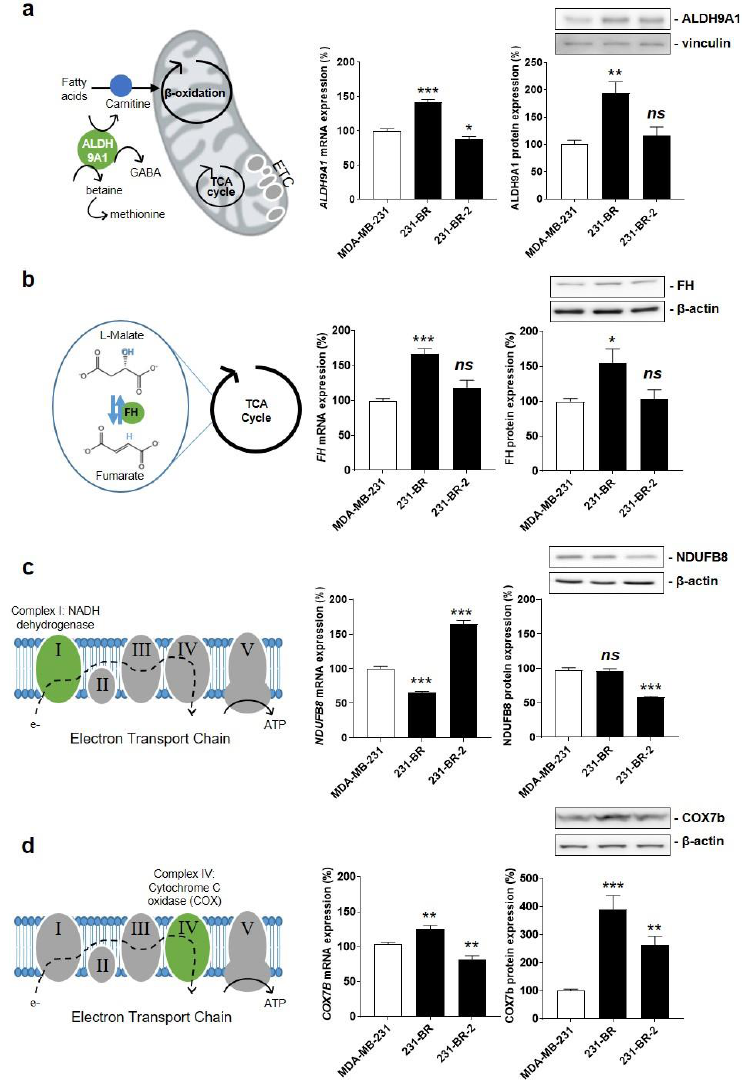
Figure 3. Identification of Cox7b as a candidate protein for the brain tropism of human breast cancer. ( a ) The left drawing depicts the three main functions of aldehyde hydrogenase 9A1 (ALDH9A1) that catalyzes the biosynthesis of γ -aminobutyric acid (GABA) in the cytosol, the biosynthesis of carnitine to facilitate the transport of fatty acids across the inner mitochondrial membrane, and the oxidation of γ -aminobutyraldehyde and aminoaldehydes derived from polyamines in the mitochondrial matrix. The middle graph shows ALDH9A1 mRNA expression normalized to β -actin ( n = 5–6), and the right graph shows ALDH9A1 protein expression normalized to vinculin ( n = 6), in MDA-MB-231, 231-BR, and 231-BR-2 cancer cells. ( b ) The left drawing depicts fumarate hydratase (FH) activity, which catalyzes the reversible hydration of fumarate to malate in the TCA cycle. The middle graph shows FH mRNA expression normalized to β -actin ( n = 5–6), and the right graph shows FH protein expression normalized to β -actin ( n = 9). ( c ) The left drawing localizes NDUFB8 as a component of electron transport chain (ETC) Complex I (green). The middle graph shows NDUFB8 mRNA expression normalized to β -actin ( n = 6), and the right graph shows NDUFB8 protein expression normalized to β -actin ( n = 3). ( d ) The left drawing depicts cyclooxygenase 7b (COX7b) as a component of ETC Complex IV (green). The middle graph shows COX7B mRNA expression normalized to β -actin ( n = 5–6), and the right graph shows Cox7b protein expression normalized to β -actin ( n = 9). All data are shown as means ± SEM. * p < 0.05, ** p < 0.01, *** p < 0.005, ns: p > 0.05; compared to MDA-MB-231 cells; using one-way ANOVA with Dunnett’s post hoc test ( a – d